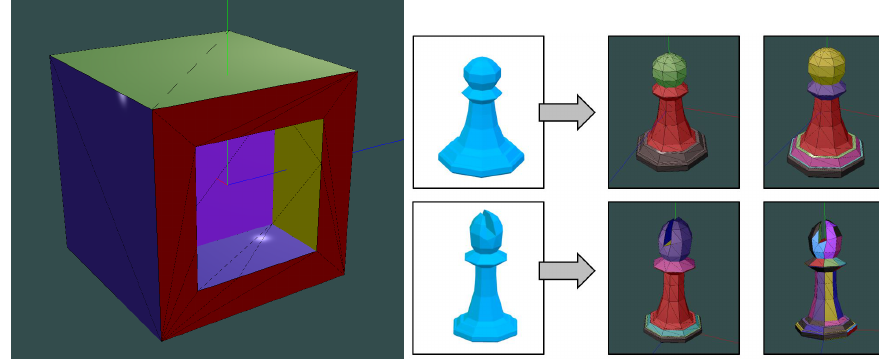
Figure 4. Training dataset to fit our method for coplanarity-based